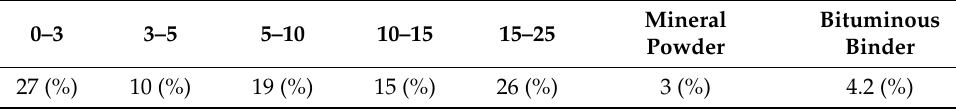
Table 5. Production mixing ratio of the AC-20 mixture.